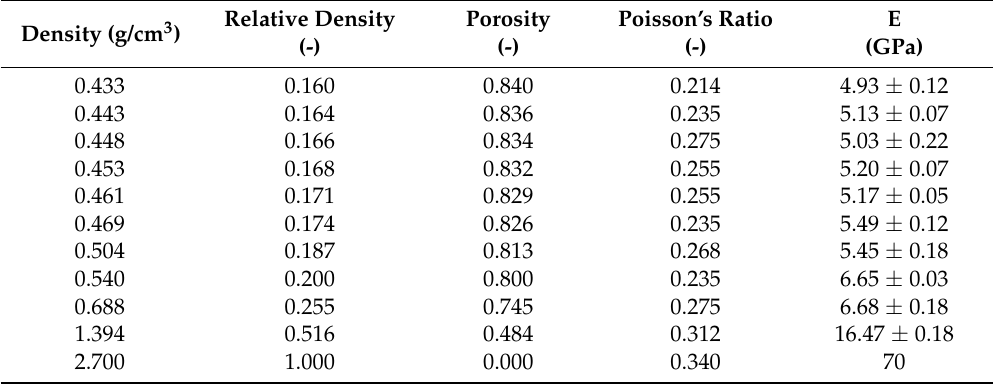
Table 1. Measured Poisson’s ratio and Young’s modulus values of pure PM aluminium